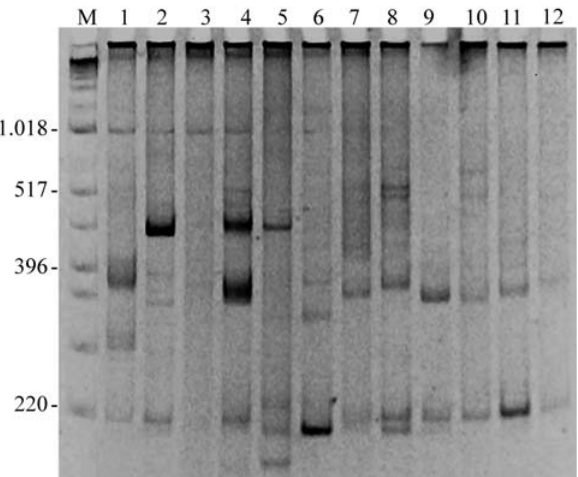
Figure1 -5SrDNAPCRproductsofSciaenidaespeciesvisualizedon6% polyacrylamide gel: (1) Larimus breviceps , (2) Nebris microps , (3) Paralonchurus brasiliensis , (4) Stellifer stellifer , (5) Menticirrhus americanus , (6) Micropogonias furnieri , (7) S. microps , (8) Ctenosciaena gracilicirrhus , (9) S. rastrifer , (10) Isopisthus parvipinnis , (11) Cynoscion jamaicensis , and (12) C. virescens. M1 and M2 represent mo- lecular mass markers of 1 kb Plus and 10 bp, respectively. The corre- sponding molecular masses are indicated on the left of the